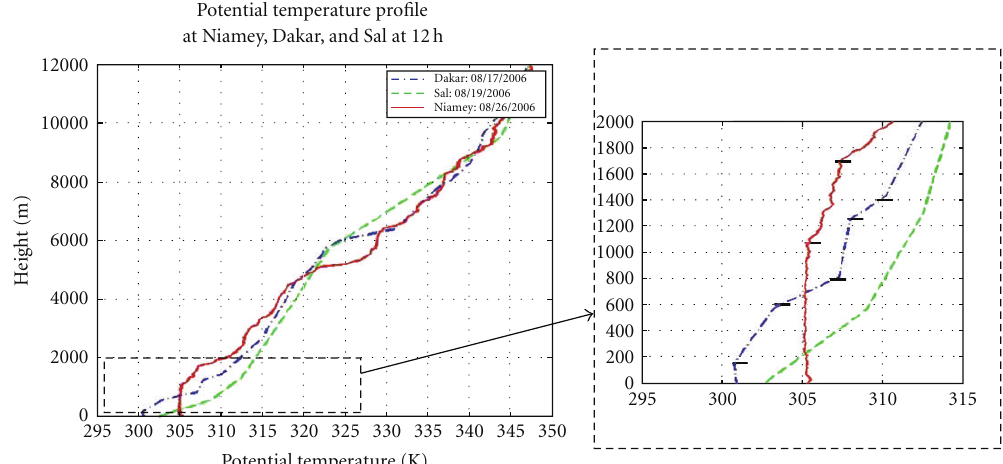
Figure 9: Profiles of potential temperature θ at 1200 UTC of 08/17/06 in Dakar (blue), of 08/26/06 in Niamey (red), and of 08/19/06 in Sal (green).